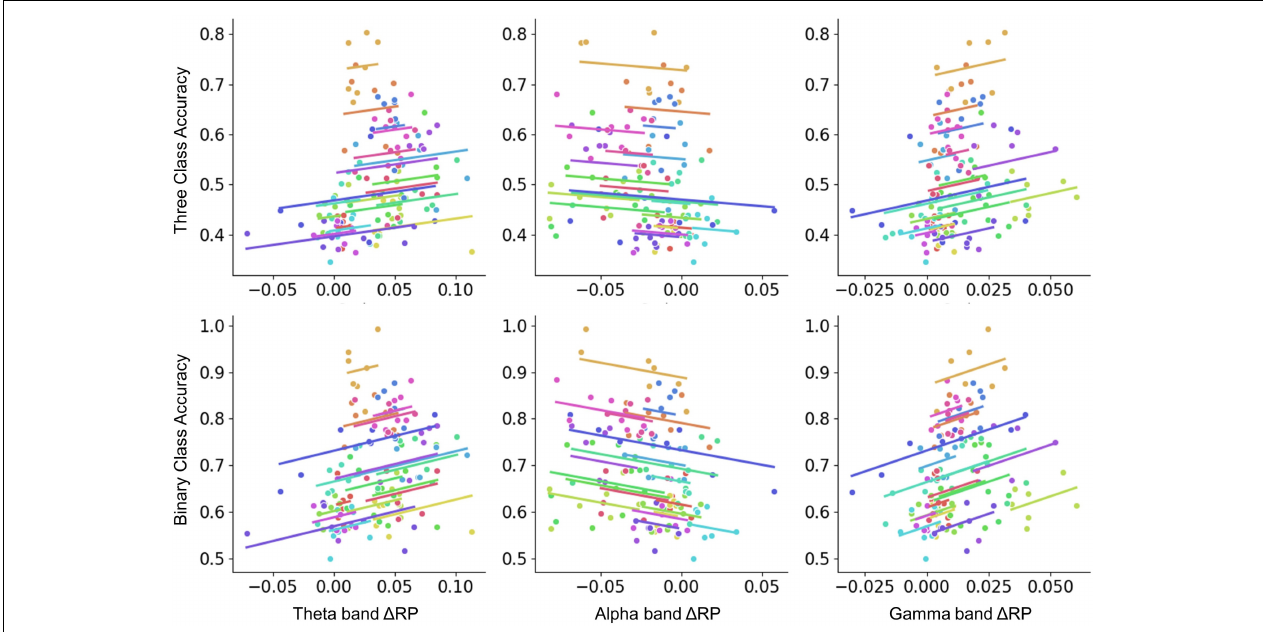
FIGURE 6 | The repeated-measures correlation between (cid:49) RP and performance across sessions. Colors identify the values obtained for the same subject across sessions. Binary-class classification accuracy was negatively correlated with alpha band (cid:49) RP factor ( r = –0.237, p < 0.001) and positively correlated with theta and gamma band (cid:49) RP factors (theta: r = 0.277, p < 0.01; gamma: r = 0.348, p < 0.001). Whereas no significant correlation was found in three-class